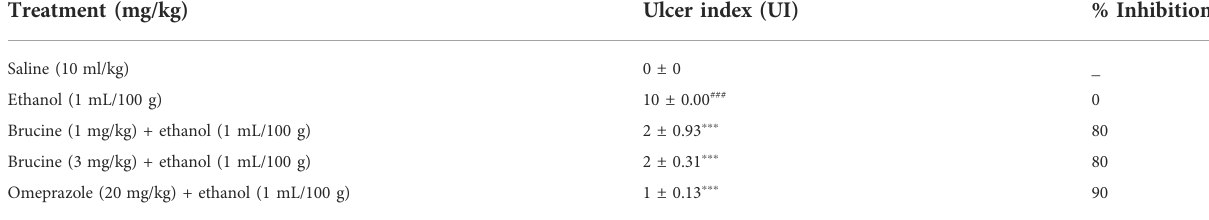
TABLE 3 Protective effect of brucine and omeprazole against ethanol-induced gastric ulcer in rats. Treatment (mg/kg)